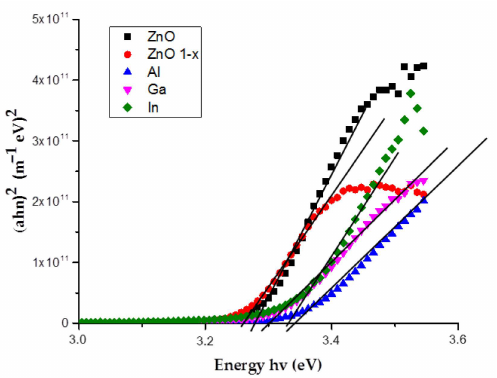
Figure 5. ( α h υ ) 2 front h υ curves of i-ZnO and ZnO doped with Al, Ga, and Figure 5. (αhυ) 2 front hυ curves of i -ZnO and ZnO doped with Al, Ga, and In.